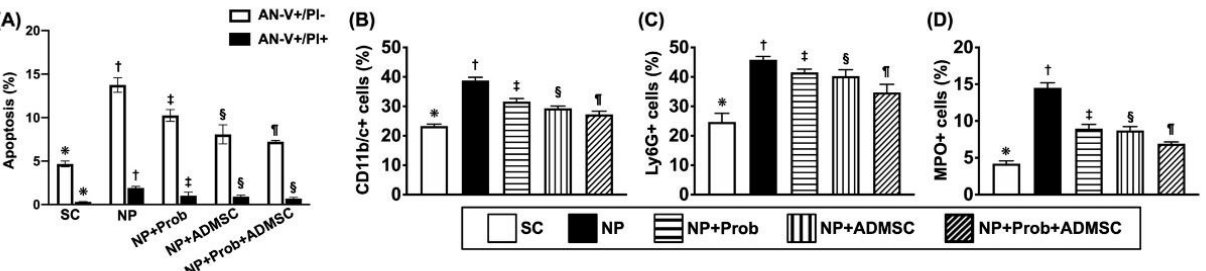
Figure 1. Flow cytometric analysis for circulatory levels of mononuclear cell apoptosis and inflamma- tory cells by day 28 after neuropathic pain (NP) induction. ( A ) Circulatory number of early apoptosis (AN-V + /PI − ) of mononuclear cells, * vs. other groups with different symbols (†, ‡, §, ¶), p < 0.0001. Circulating level of late apoptosis (AN-V + /PI + ) of mononuclear cells, * vs. other groups with different symbols (†, ‡, §), p < 0.0001. ( B ) Circulating number of CD11b/c+ cells, * vs. other groups with different symbols (†, ‡, §, ¶), p < 0.0001. ( C ) Circulating number of Ly6G+ cells, * vs. other groups with different symbols (†, ‡, §, ¶), p < 0.0001. ( D ) Circulating number of myeloperoxidase (MPO)+ cells, * vs. other groups with different symbols (†, ‡, §), p < 0.0001. Symbols (*, †, ‡, §, ¶) indicate significance (at 0.05 level). All statistical analyses were performed using one-way ANOVA followed by Bonferroni multiple comparison post hoc test (n = 4 for each group). SC = sham control; ADMSCs = adipose-tissue-derived mesenchymal stem cells.